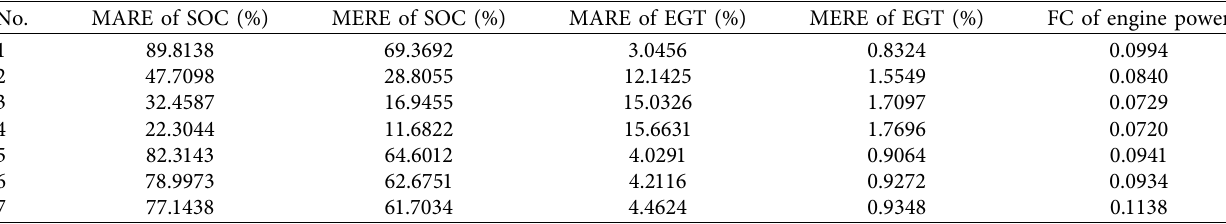
Table 8: Simulation results comparison.